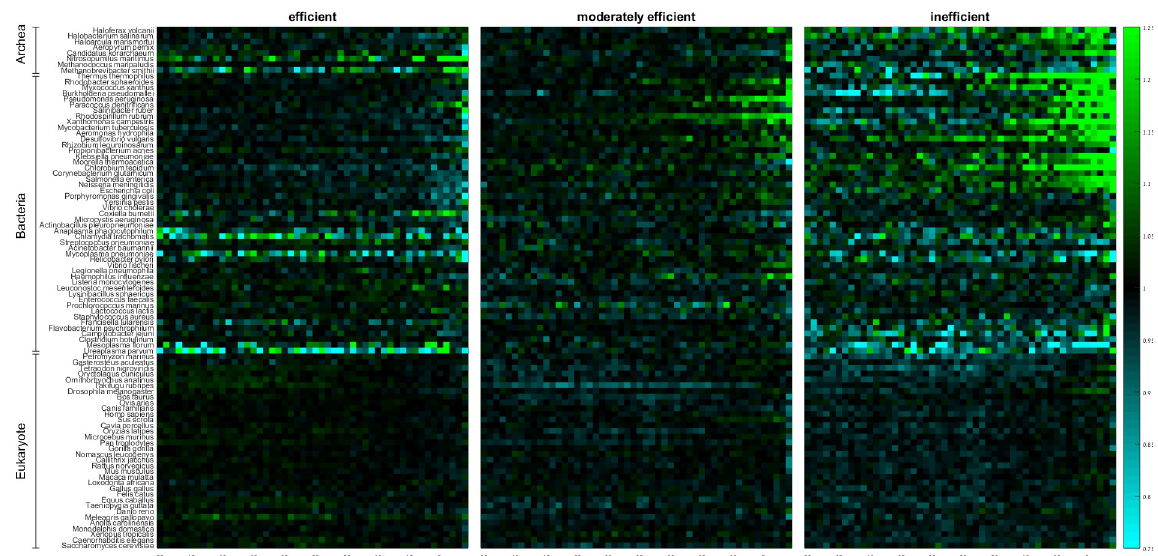
Fig 4. Group RSCA scores of efficient, moderately efficient, and inefficient codons along the last 50 codons of the gene. Rows denote species, columns denote positions. Species within domains are sorted from high (top) to low (bottom) GC-content.